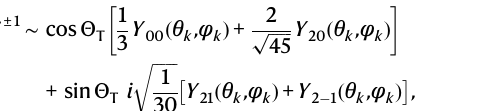
Fig. 3a, the SPA results accurately predict the weights of the different partial waves.